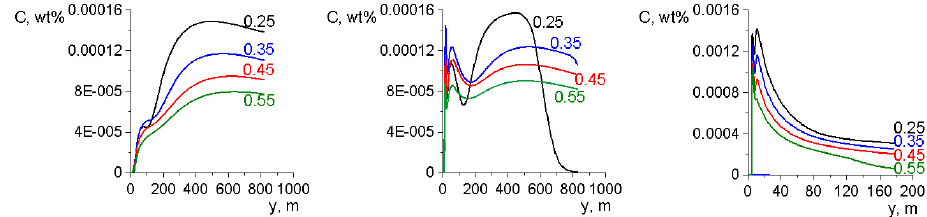
Fig. 12. Longitudinal evolution of the pollutant concentration at the seabed; (left) L = 0 . 5m; (middle) L = 0 . 25 and (right) in the case of blockage.